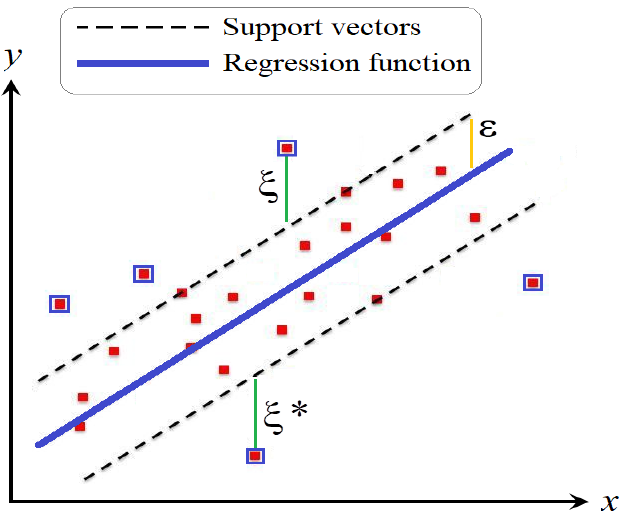
Figure 2. A schematic diagram of the two-dimensional feature space mapped data using a linear SVR. Thus, kernel functions are used to cope with this problem to map the available